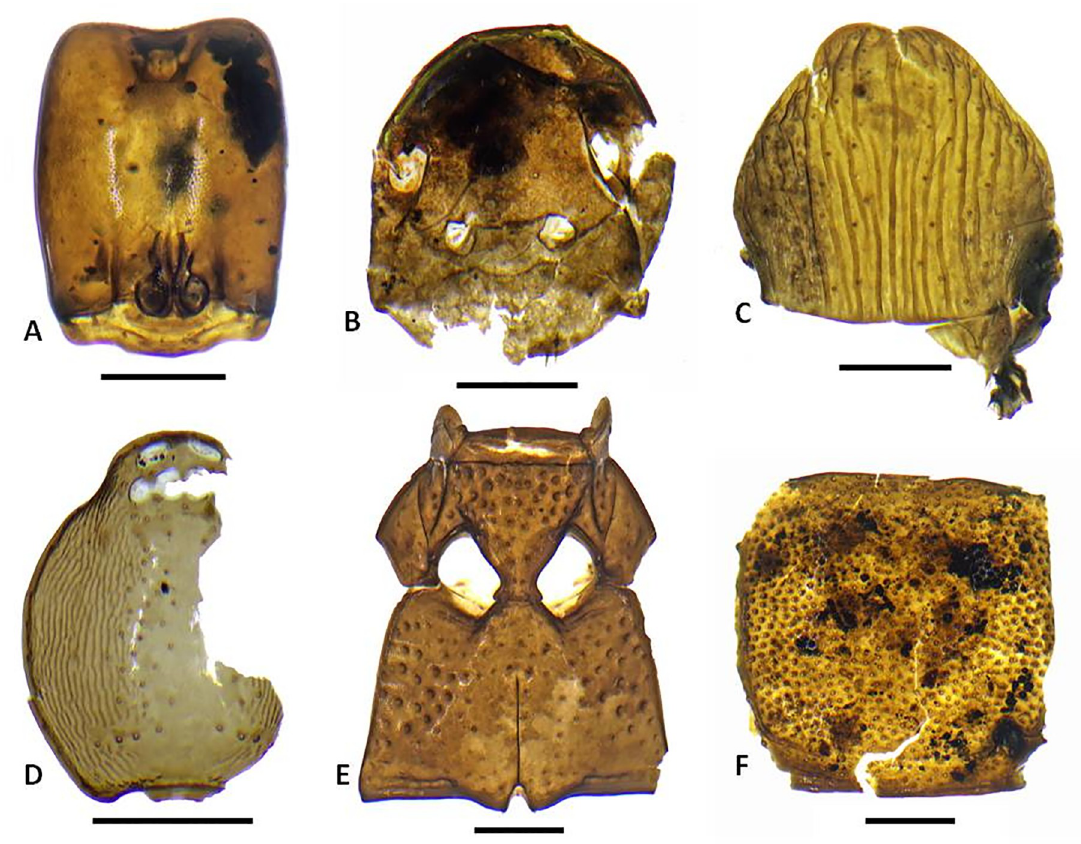
Fig 13. Representative insect subfossils of likely introduced taxa. A. Hypoponera cf . punctatissima ant (Formicidae) head; B. Nylanderia sp . ant (Formicidae) head; C. Tetramorium bicarinatum ant (Formicidae) queen pronotum; D. Opopaea-type spider (Oonopidae) spider carapace; E, F. Cryptamorpha desjardinsii (Silvanidae) (meso- and metaventrites (E) and prothorax (F). Scale bars all 0.25 mm. (Photo by N.